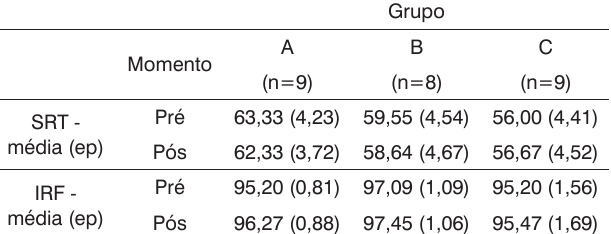
Tabela 4. Limiar de reconhecimento da fala (SRT) e a discriminação vocal (IRF) - médias e erros padrão (ep) ajustados para dependência entre as medidas do mesmo paciente.